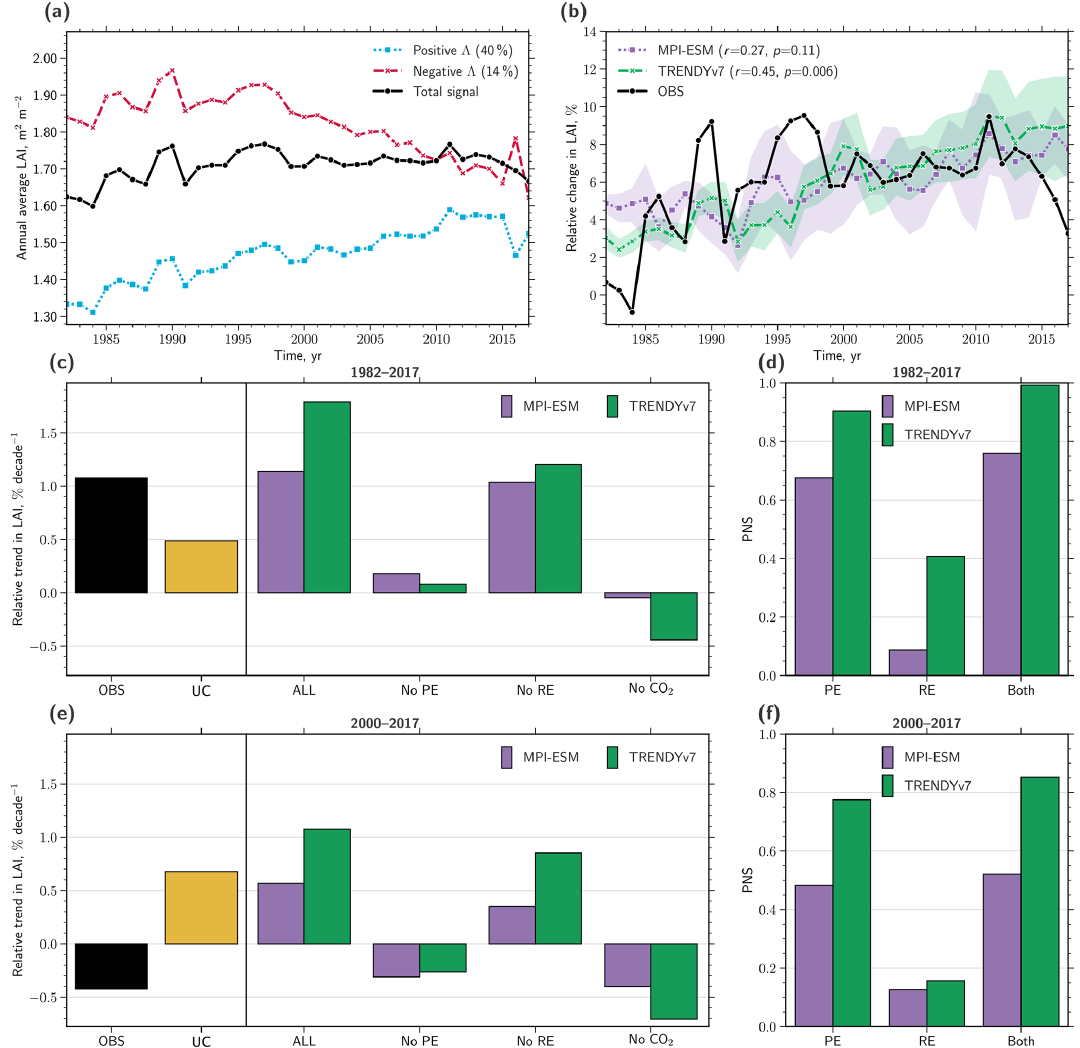
Figure 4. Driver attribution of changing natural vegetation at the global scale: neglecting ecosystem heterogeneity could lead to misleading results. (a) Time series of the area-weighted annual average LAI (GIMMS LAI3g, 1982–2017) for regions of positive (dotted blue line) and negative (dashed red line) sensitivity to rising atmospheric CO 2 concentration ( (cid:51) ) of natural vegetation. Solid black line represents the overall signal of all pixels. The percentages in parentheses in the legend represent the greening and browning proportions with respect to the total area. (b) Time series of changes in LAI relative to the average state from 1982–1984, comparing observations (solid black line) with historical simulations, where the dashed green line denotes the ensemble mean of 13 offline-driven land surface models (TRENDYv7, “Materials and methods”) and the dotted purple line denotes the average of an ensemble of multi-realizations with a fully coupled Earth system model (MPI- ESM, “Materials and methods”). The colored shading represents the 95% confidence interval estimated by bootstrapping. The correlation coefficients (including significance level) of the observed and simulated time series are displayed in parentheses in the legend. (c) Bar chart showing relative trends in LAI (in %yr − 1 ) of the total observed signal (black) and for factual (all historical forcings, ALL) as well as for counterfactual simulations, i.e., no historical CO 2 forcing (No CO 2 ) and all historical forcings except the physiological effect (No PE) or the radiative effect (No RE) of atmospheric CO 2 , as estimated by TRENDYv7 (green) and the MPI-ESM (purple). The yellow bar represents the overall uncertainty (UC) including inter-model variations derived from all simulations (control, factual, and counterfactual). (d) Probabilities of necessary and sufficient causation (PNS) of the change in LAI, comparing the physiological effect (PE) and radiative effect (RE) of CO 2 as well as their combined effect (Both). (e) Same as in (c) but for the period 2000–2017. (f) Same as in (d) but for the period